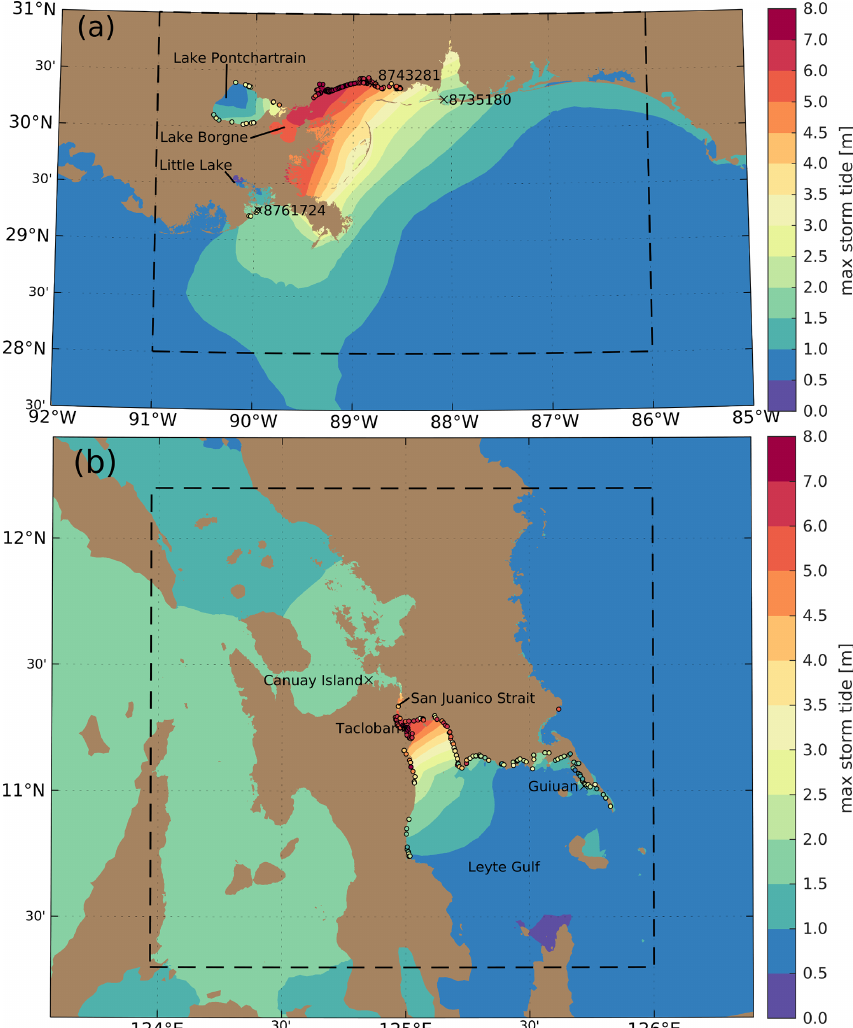
Figure 9. Maximum simulated storm tide elevations on the MinEle = 150m local refinement meshes compared to coastal-surge-attributed high-water marks that are located within 1.5km of the mesh coastline (filled circles). Black annotated crosses indicate the locations where storm tide time series are plotted. (a) Maximum simulated elevations due to Hurricane Katrina in the Louisiana–Mississippi landfall region. A value of 0.23m has been added to account for a steric offset and the conversion to NAVD88 vertical datum from local mean sea level. (b) Maximum simulated elevations due to Super Typhoon Haiyan in the Leyte and Samar Island, Philippines, landfall